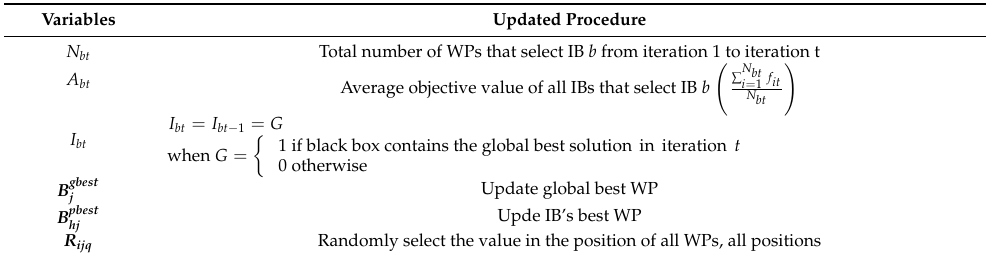
Table 9. The updated role of the heuristic